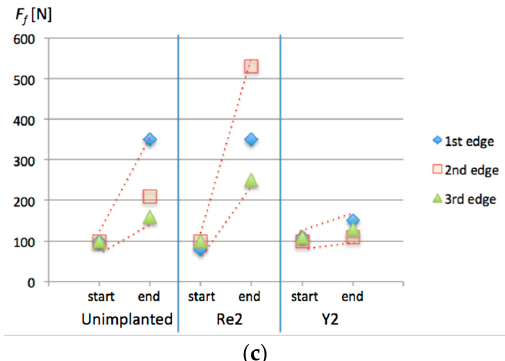
Figure 8. Registered force components: ( a ) F p ; ( b ) F c ; ( c ) F f . The respective symbols along X-axis denote